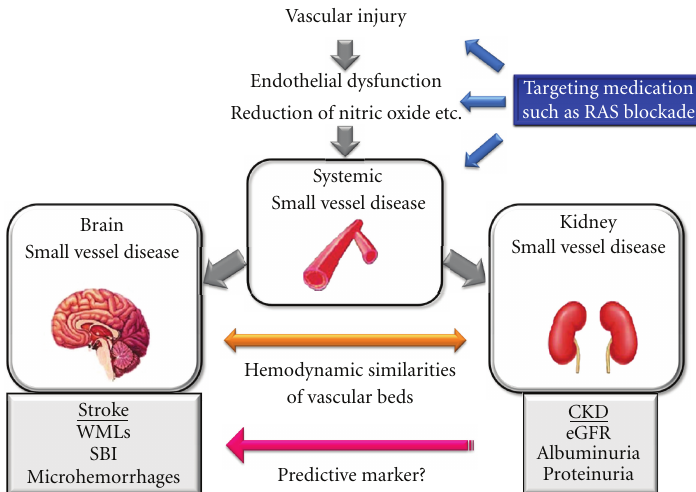
Figure 1: Schematic representation of cerebrorenal connection. RAS: renin-angiotensin system, CKD: chronic kidney disease, eGFR: estimated glomerular filtration rate, WMLs: white matter lesions, and SBI: silent brain